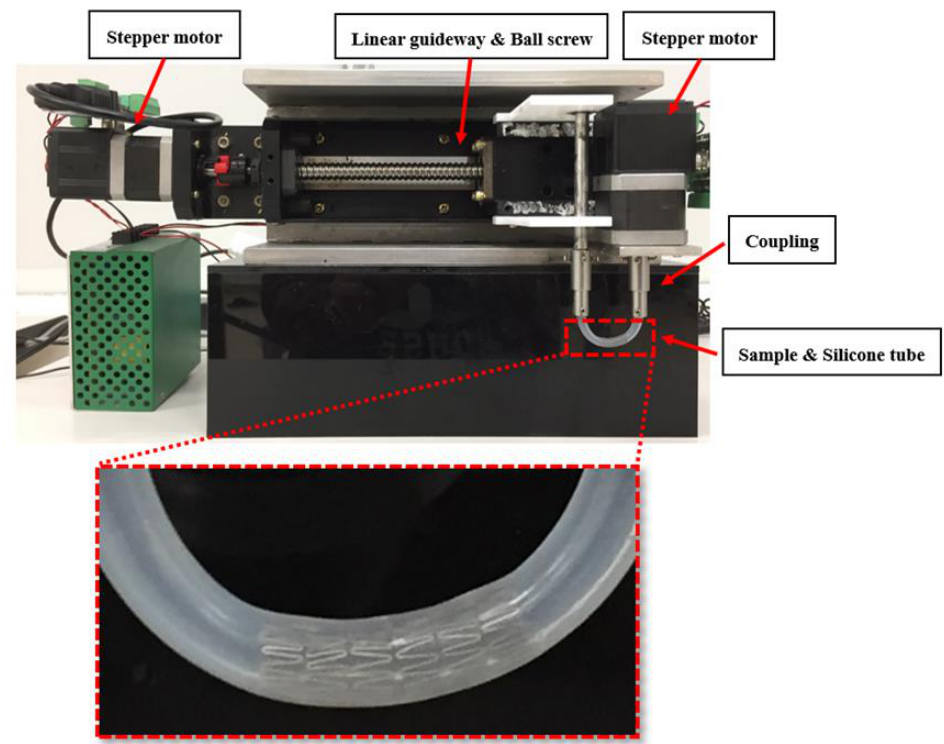
Figure 6. Rotating bending fatigue tester for a transparent tube with a stent deployed inside.